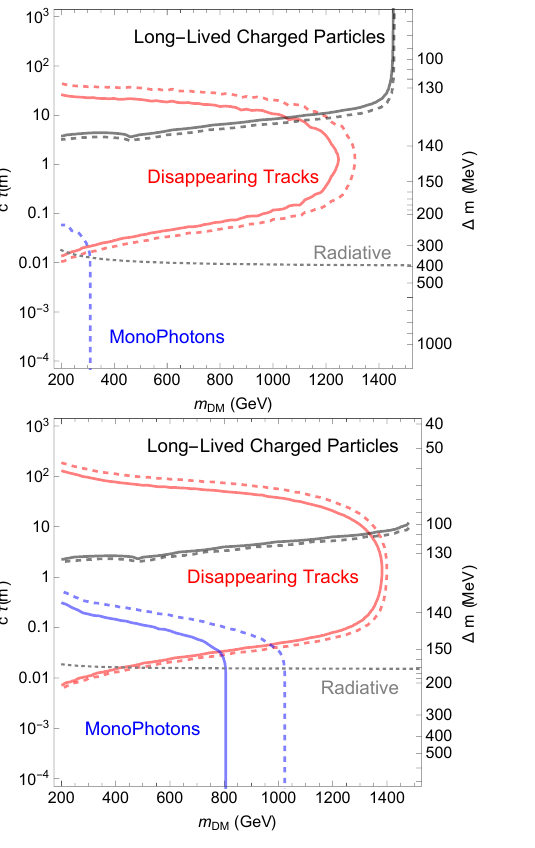
Figure 11 . Combined exclusion and discovery plots for fermionic EMDM in the mass-lifetime plane. Top row: complex doublet (left) and real triplet (right). Bottom row: real quintet (left) and real septet (right). The di(cid:11)erent contours describe the searches from sections 4, 5 and 6 as labelled. The line marked ‘Radiative’ shows the mass splitting generated purely from radiative corrections. See the text for additional